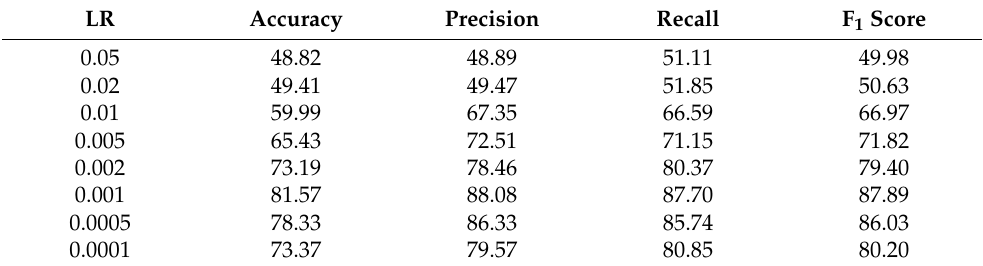
Table 3. Comparison of the multiclassification metrics at different learning rates.